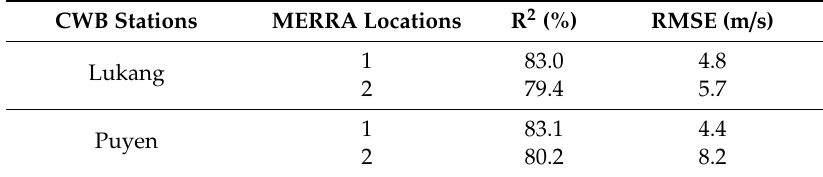
Table 7. Correlation and RMSE of the wind speed for measured floating LiDAR data and floating LiDAR data simulated through MCP by using CWB data and MERRA data.